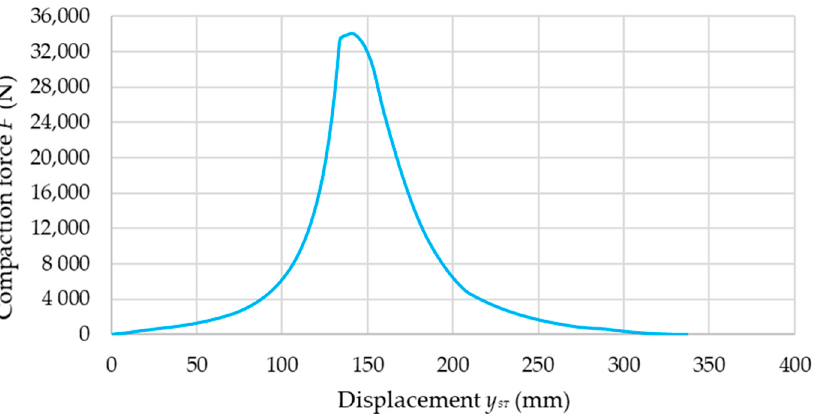
Figure 10. Characteristic curve of the variance in the compaction force in the course of the compaction–unloading cycle of oak sawdust when compacted with a force F = 34,000 N.